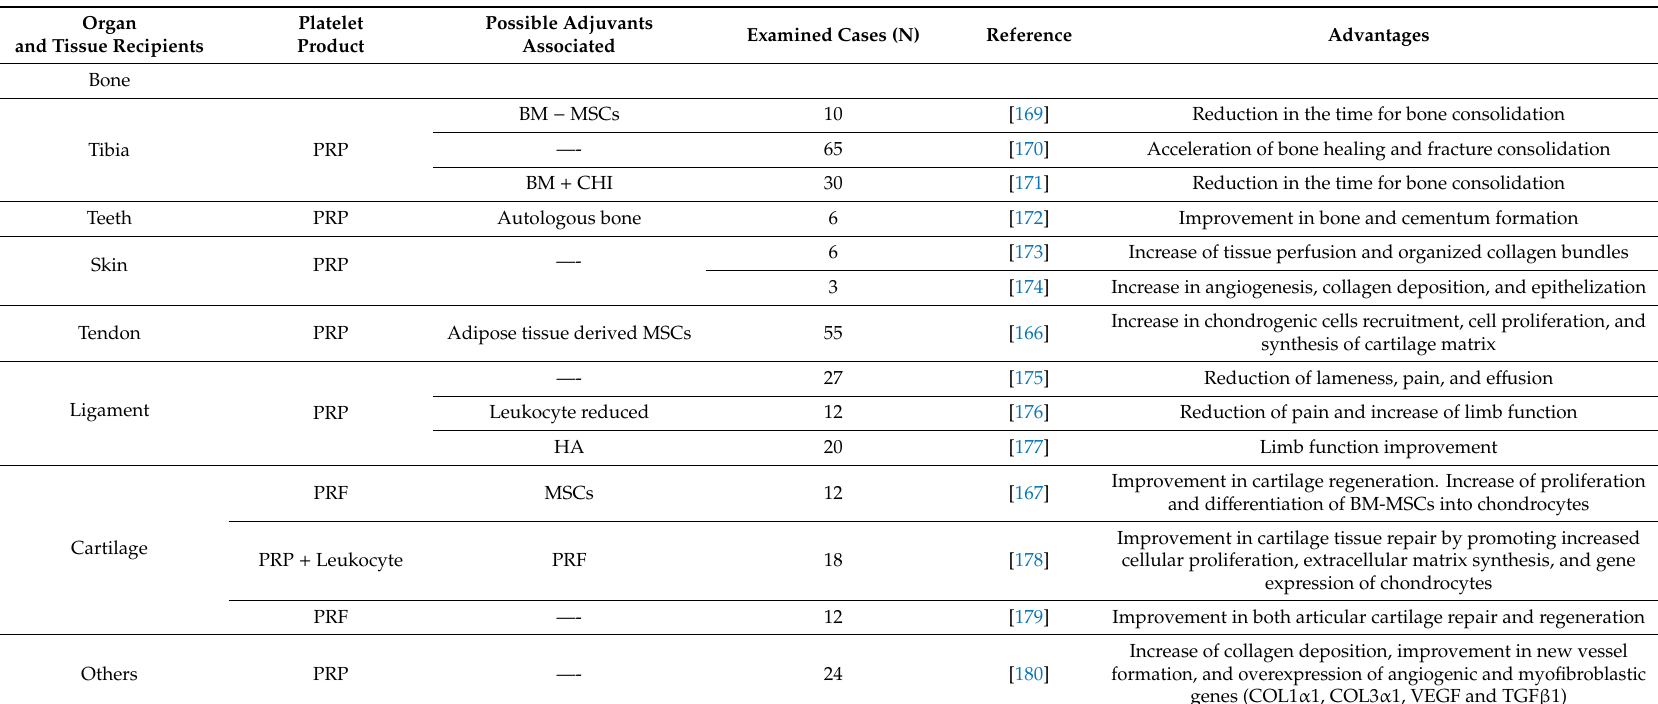
Table 4. Applicative use of dog platelets and their derivatives in di ff erent tissues or organs for regenerative